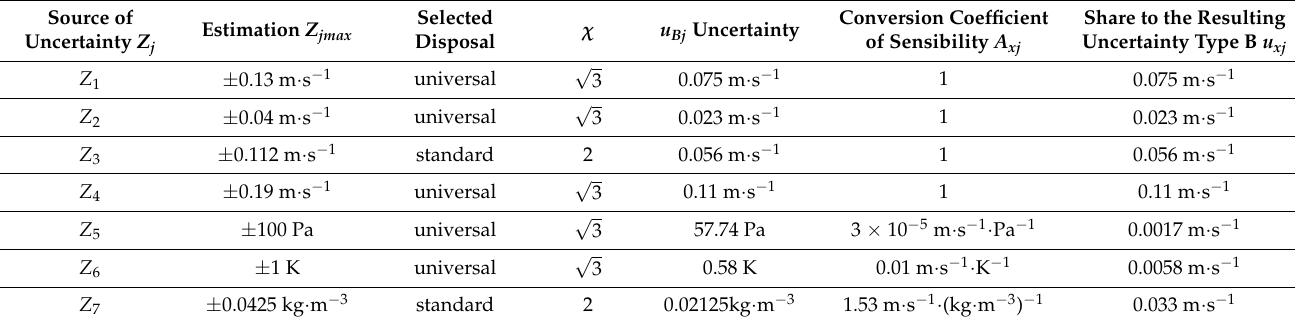
Table A2. Balance of the standard uncertainty type B of the measurement of the vertical parachute speed. Source of Estimation Z Uncertainty Z j